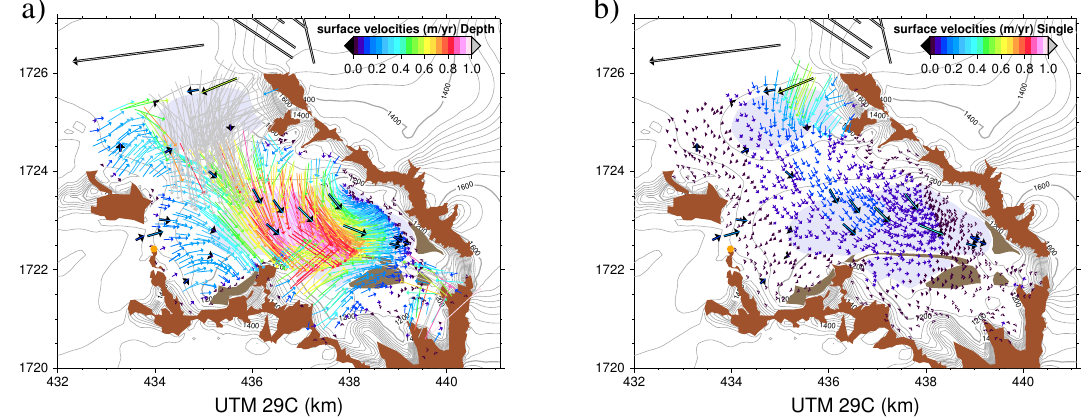
Fig. 7. Surface velocity (vectors) for the anisotropic flow law using (a) a depth-dependent fabric and (b) a single maximum fabric distribution. The surface velocities in the depth-dependent anisotropic case (a) are not significantly altered with respect to the isotropic case. However, applying a single maximum fabric reduces velocities (even reducing them too much) and produces better agreement in direction.